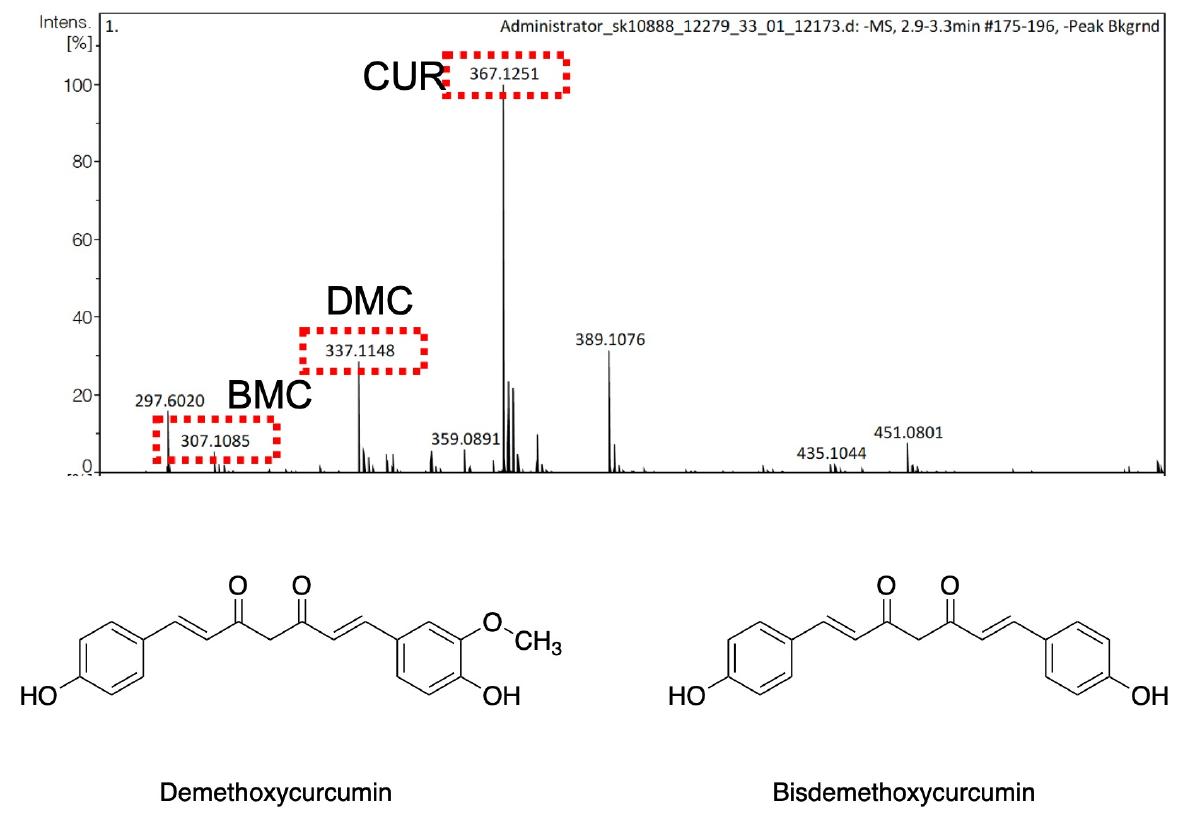
Figure 4. The LC − MS spectra of the >65% CUR product ( top ) and the chemical structures of the identified impurities ( bottom ). CUR stands for curcumin.